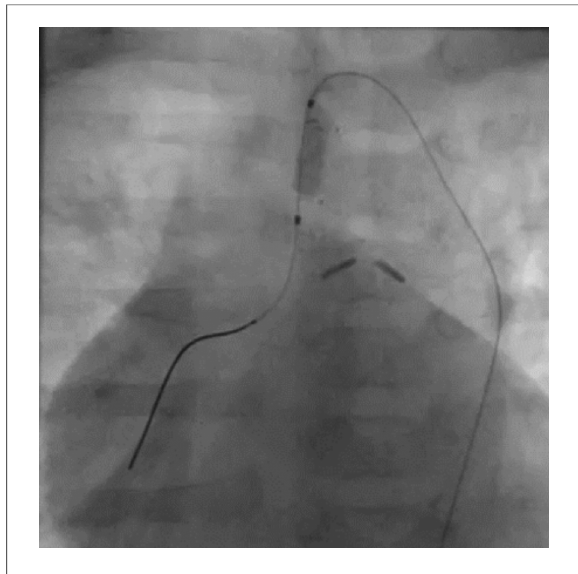
FIGURE 2 Intraprocedural frame of the mini-Tyshak balloon (NuMED For Children, Orlando, FL, United States) and MRBT shunt radiopaque reference